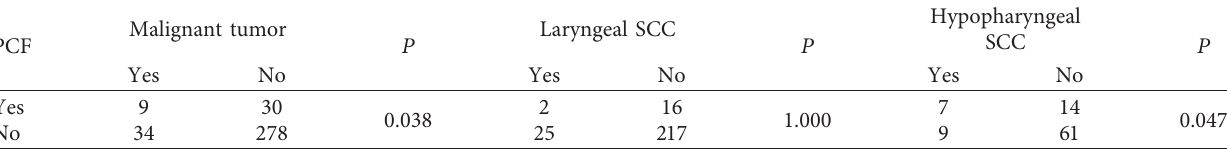
Chi-square tests